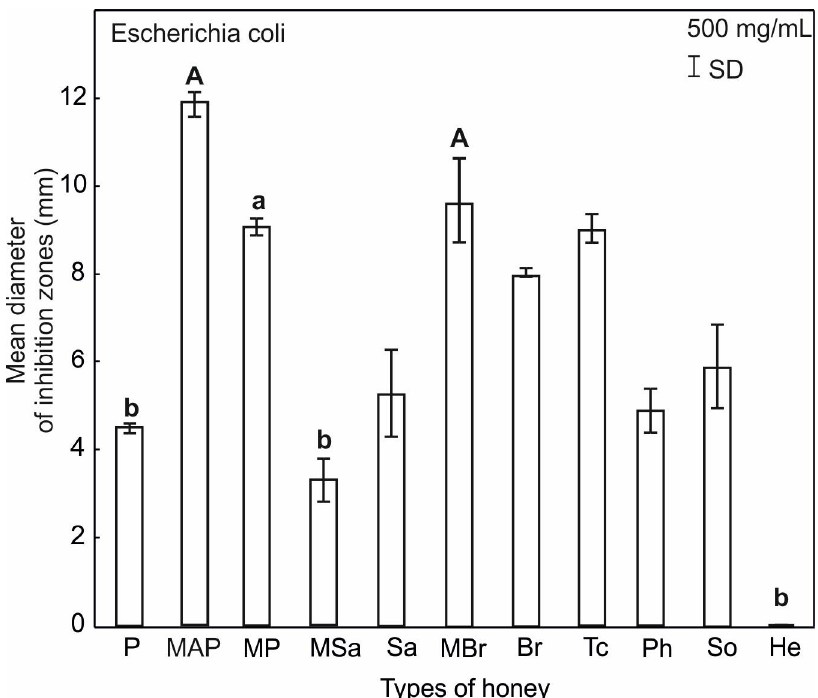
Figure 5. Results of ANOVA Kruskal–Wallis H test for the mean inhibitory activity of all tested honey types against E. coli . Statistical differences are indicated by different letters and their significance at p ≤ 0.001 with capital letters (A), p ≤ 0.05 with small letters (a). Upper and lower case letters above the bars indicate different levels of statistical significance.